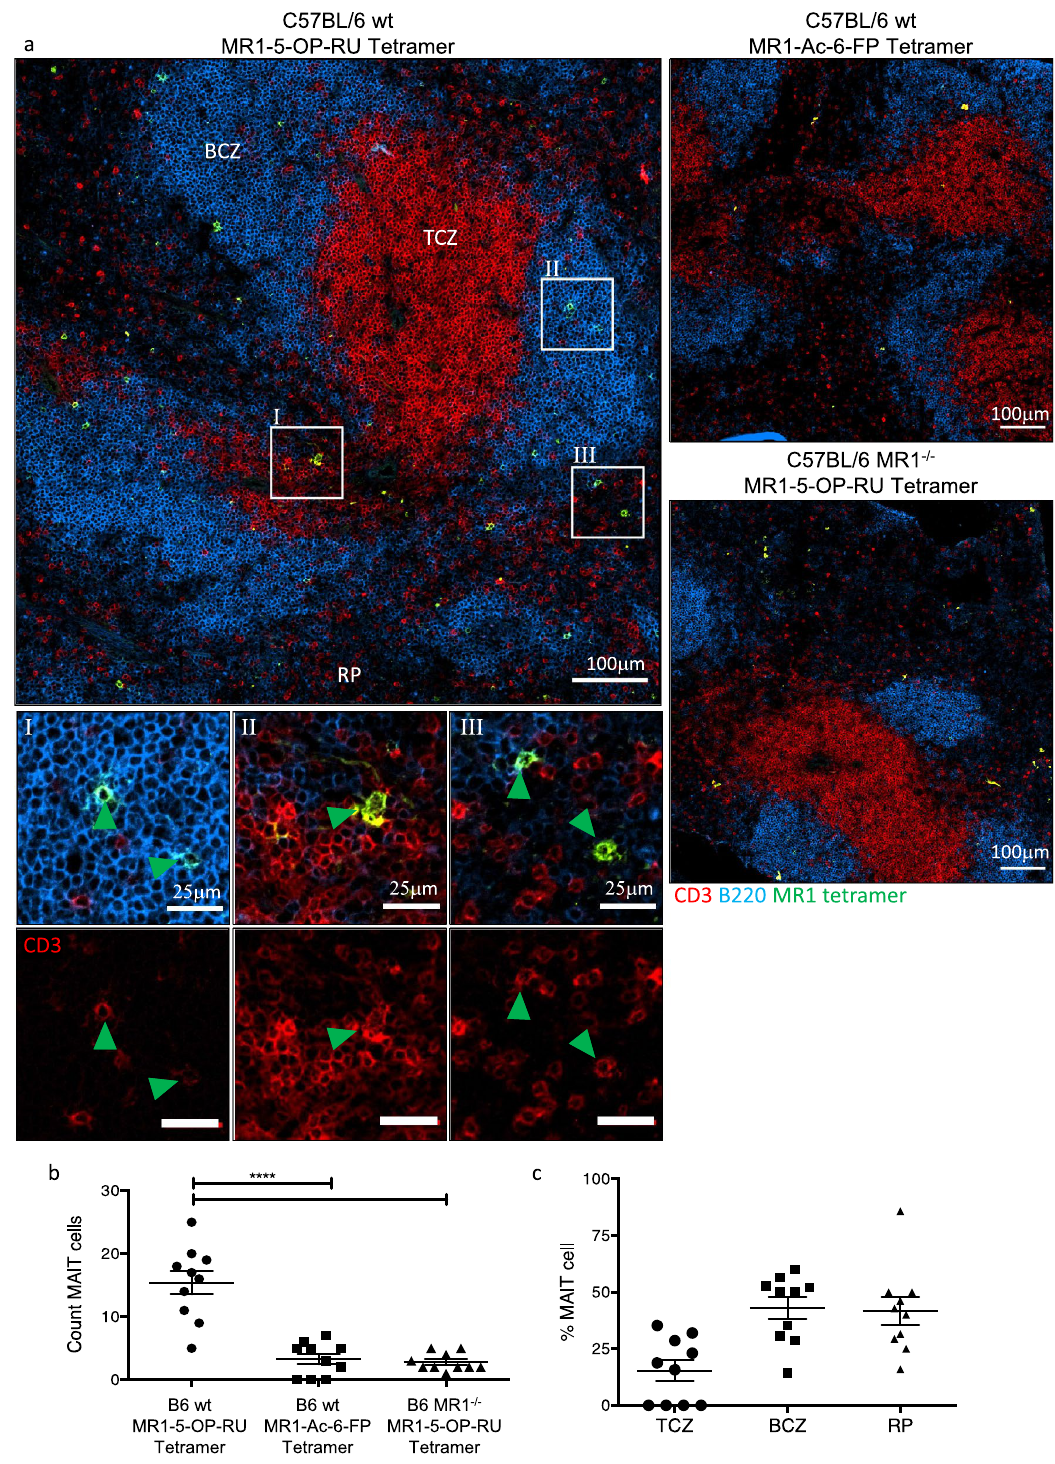
Figure 8. Identification of MAIT cells within WT mouse spleen in situ. 7 μm sections of spleens from B6 WT or B6.MR1 −/− mice stained with MR1 tetramers loaded with 5-OP-RU or Ac-6-FP and anti-B220 and CD3 antibodies. ( a ) Representative images showing MR1 tetramer (green), B220 (blue) and CD3 (red) staining within splenic red pulp (RP), B cell zone (BCZ) and T cell zone (TCZ) of the splenic white pulp, scale bar 100 μm with corresponding zoomed regions of interest as shown, scale bar 25 μm. ( b ) Count of MR1-5-OP-RU tetramer + CD3 + MAIT cells per 0.63 mm 2 image and c proportion of MAIT cells within each splenic region of the total number of NKT cells per image. Microscopy images acquired with Zen 2012 (ZEISS ZEN Microscope Software for Microscope Components) and processed with FIJI/ImageJ (Fiji (imagej.net)) and Imaris 9.3 (Microscopy Image Analysis Software—Imaris—Oxford Instruments (oxinst.com)) and figure compiled with Microsoft PowerPoint (Microsoft PowerPoint Slide Presentation Software|Microsoft 365). Mean ± SEM, symbols represent each mouse of n = 10 mice combined from 2 independent experiments, one-way ANOVA with Dunnett’s post-hoc test, **** = p <